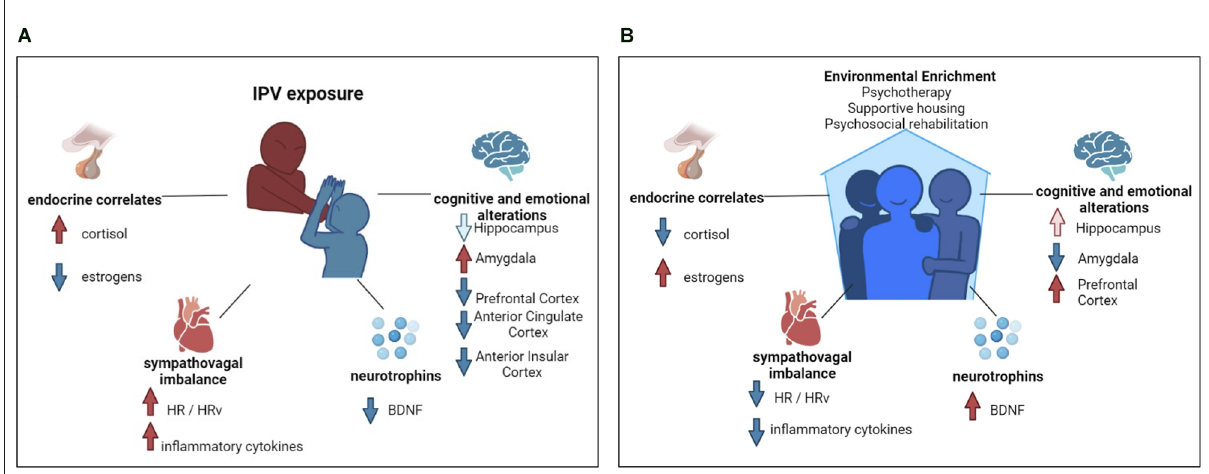
FIGURE1 Flow chart of intimate partner violence’s psycho-physio-pathological sequelae and environmental enrichment beneficial effects. (A) Graphical representation of biopsychological sequela of intimate partner violence survivors. Red arrows indicate an increase; blue arrows indicate a decrease. In the graphical representation of cognitive and emotional alterations, the light blue arrow indicates brain structure volumetric decrease, whereas the red and the blue arrow indicate functional alterations. (B) Graphical representation of the biopsychological benefits of environmental enrichment. Red arrows indicate an increase; blue arrows indicate a decrease. In the graphical representation of cognitive and emotional alterations, the light red arrow indicates brain structure volumetric increase, whereas the red and the blue arrow indicate functional